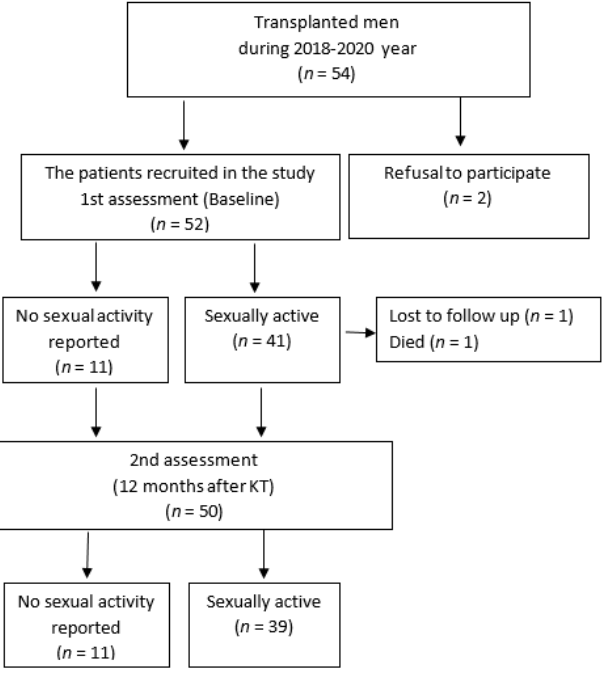
Figure 1. Study flowchart